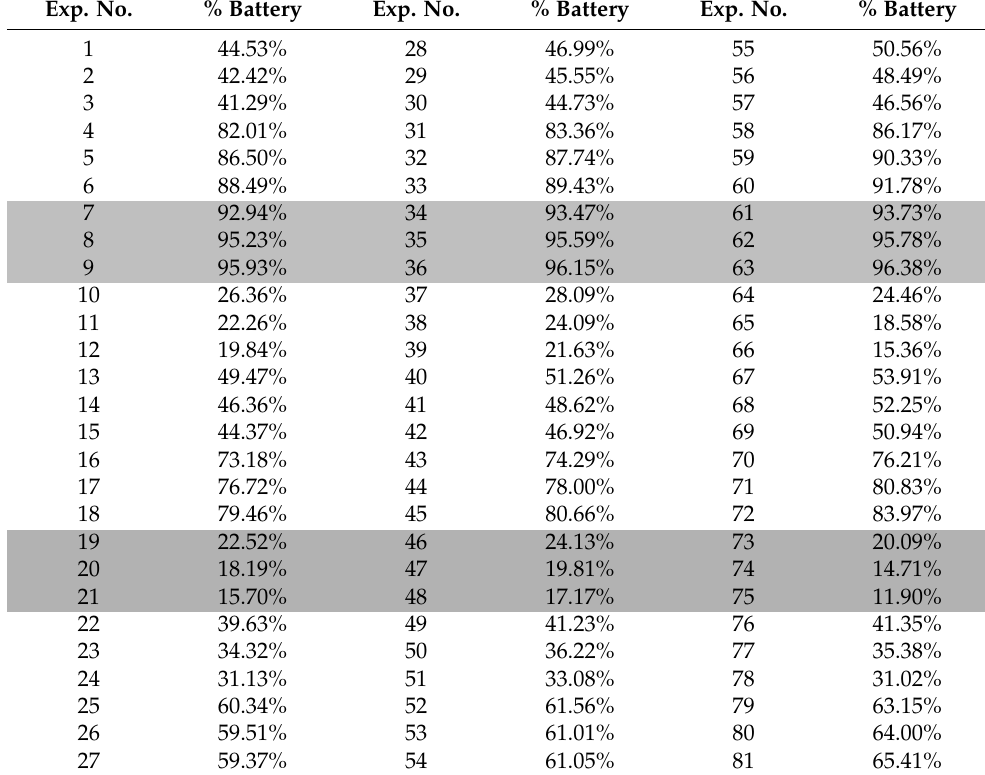
Table 5. Average utilization of the battery